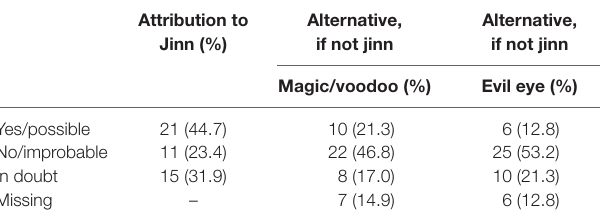
TaBle 2 | Attribution of mental health symptoms to jinn ( n = 47).